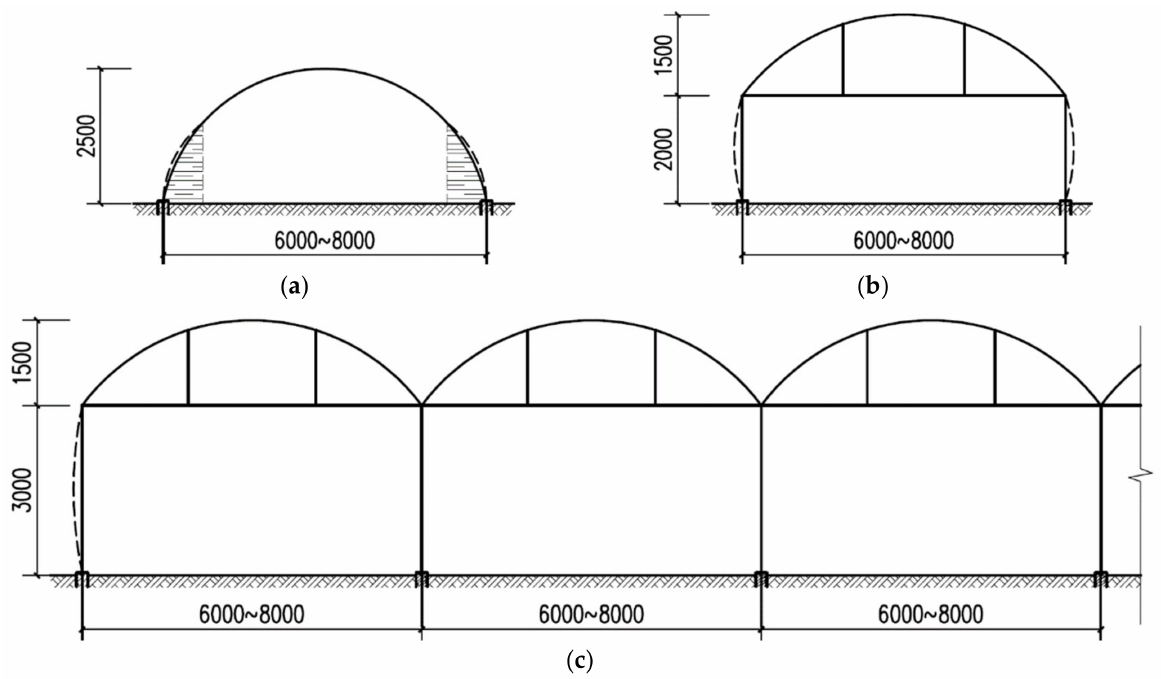
Figure 1. Evolution of the round-arch greenhouse structure (unit: mm). ( a ) Floor-type round-arch greenhouse structure; ( b ) Upright side wall type single arch greenhouse structure; ( c ) Multi-span round-arch greenhouse